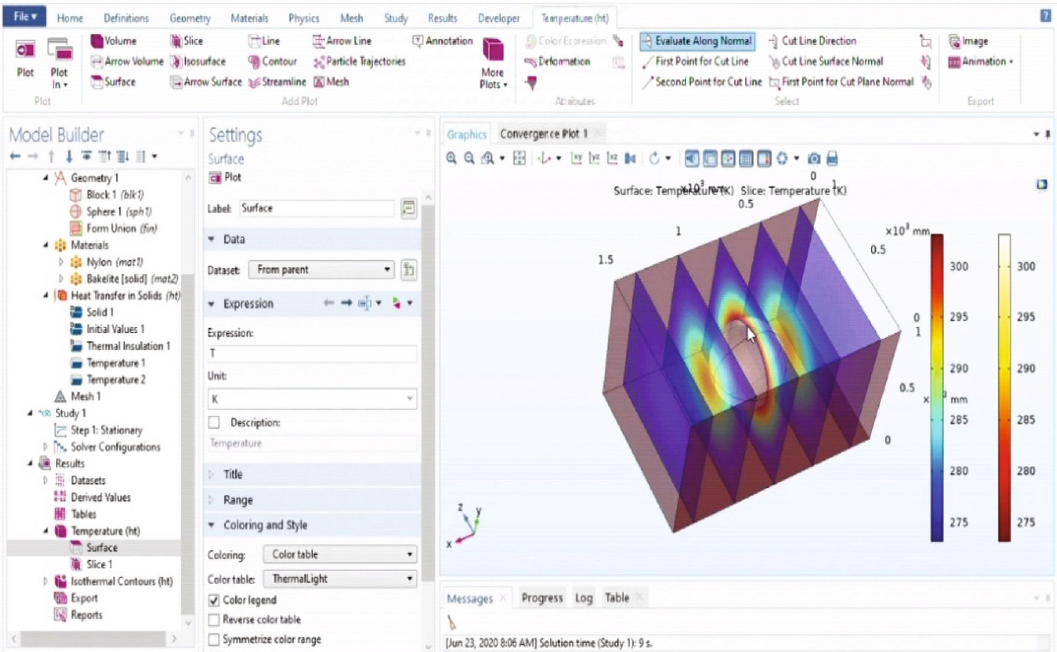
Figure 5: Heat transfer from Bakelite to